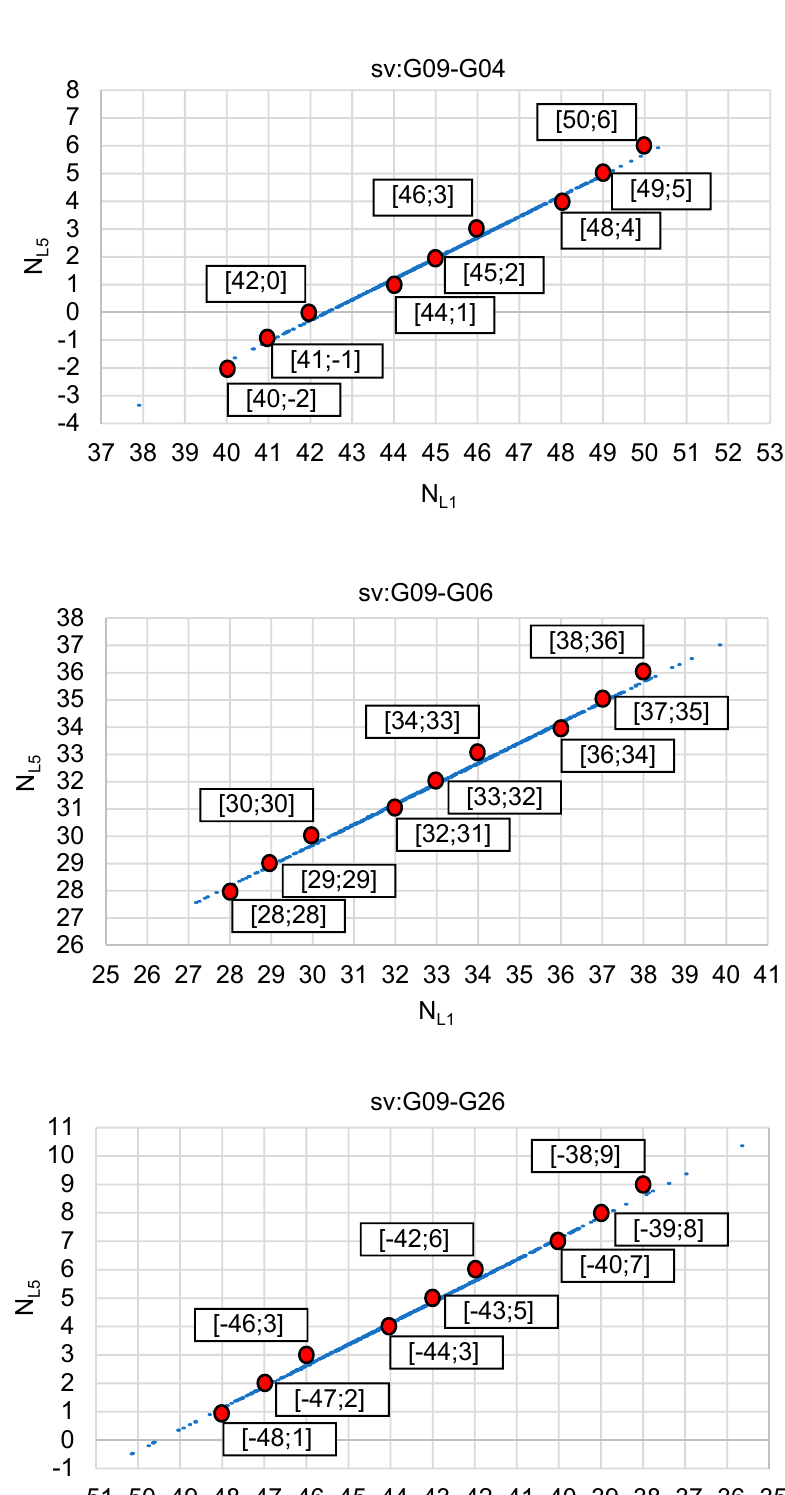
Figure 9. Integer candidates of ambiguity initialization for satellites: G09–G04, G09–G06, G09–G26 if the relative errors of carrier phases L1–L5 are below 10 cm, with the use of the PREFMAR approach.